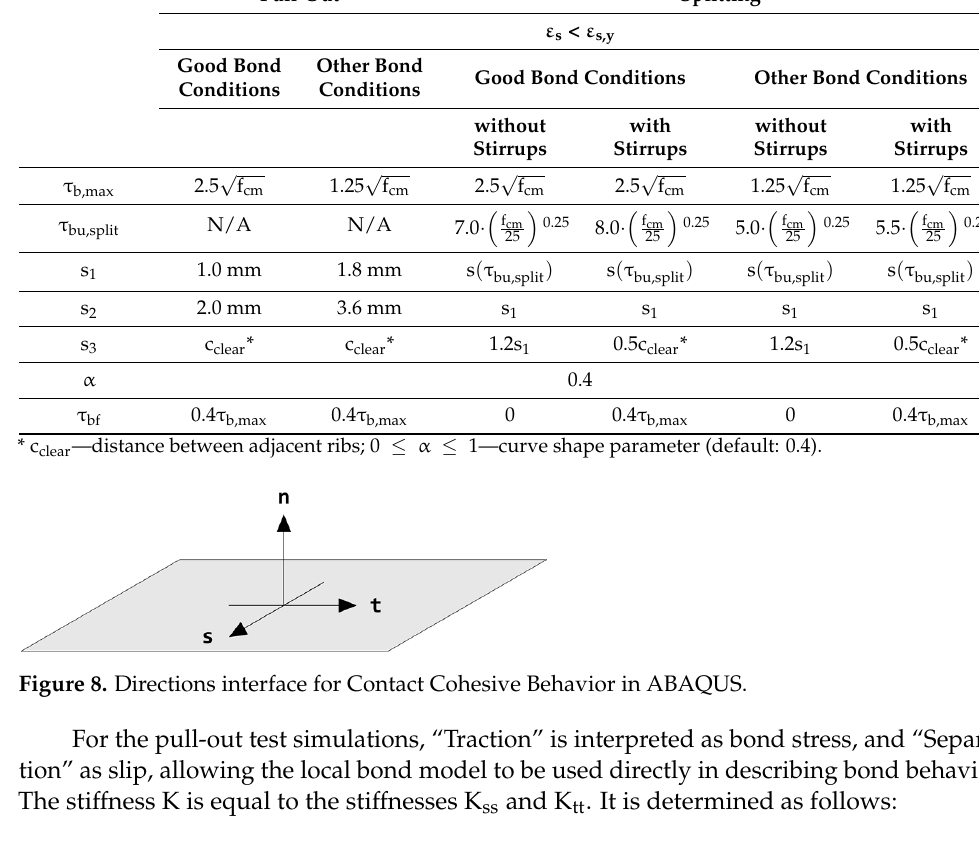
Table 9. Definition of characteristic points of the bond model acc. MC2010 [4] for deformed bars. Pull-Out Splitting ε s < ε s,y Good Bond Other Bond Good Bond Conditions Other Bond Conditions Conditions Conditions